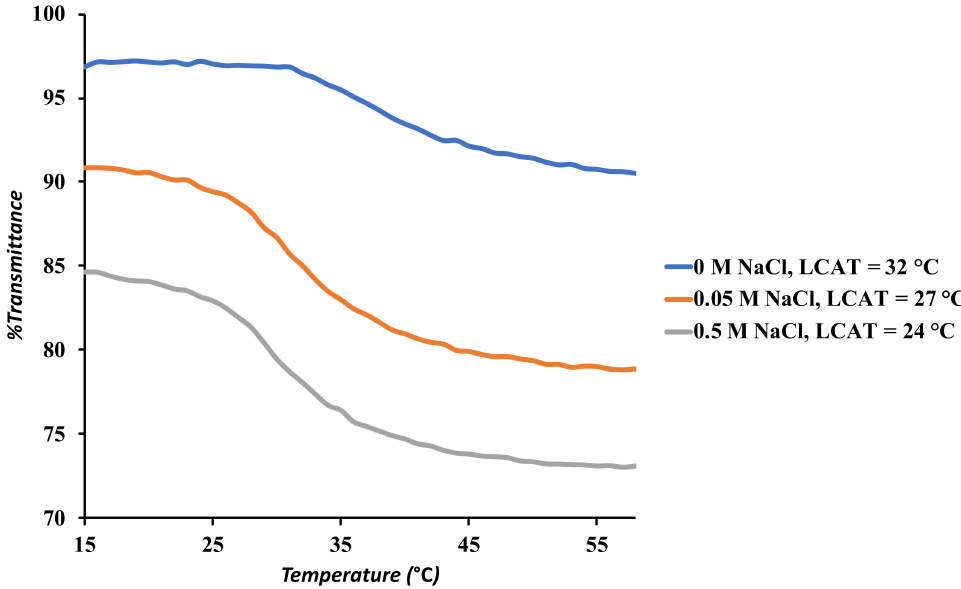
Figure 8. Transmittance curves as a function of temperature for 1 mg/mL solutions of SNP- g - PMEO 2 MA (15%, DS 0.022) at different NaCl